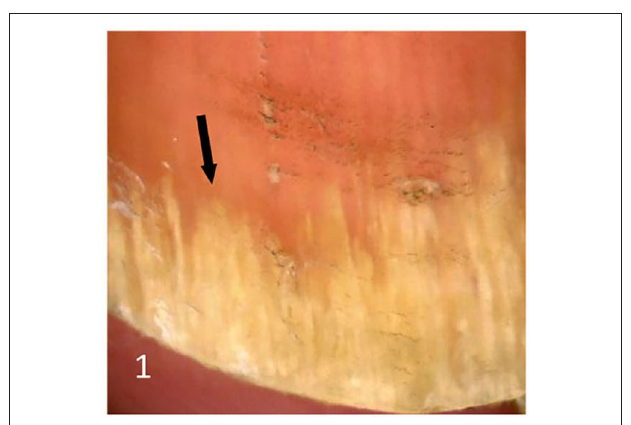
FIGURE 1 | Jagged distal nail plate